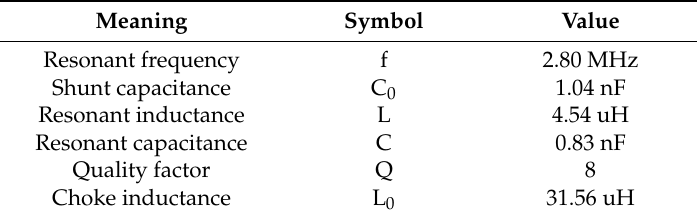
Figure 9. The equivalent circuit diagram with the Class-E amplifier. Table 2. Parameters of the proposed Class-E amplifier.